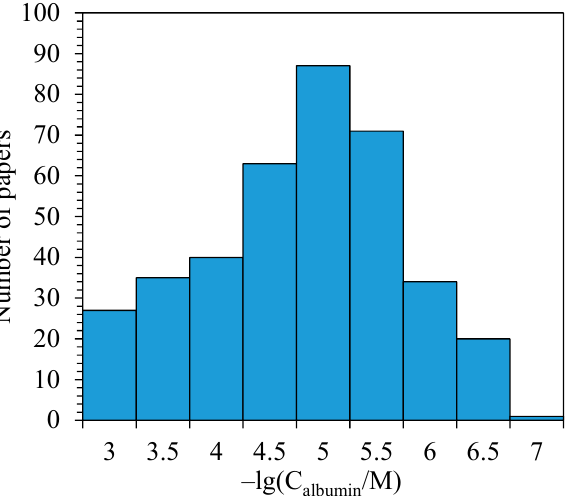
Figure 3. Number of papers in the dataset using different maximum albumin concentrations .